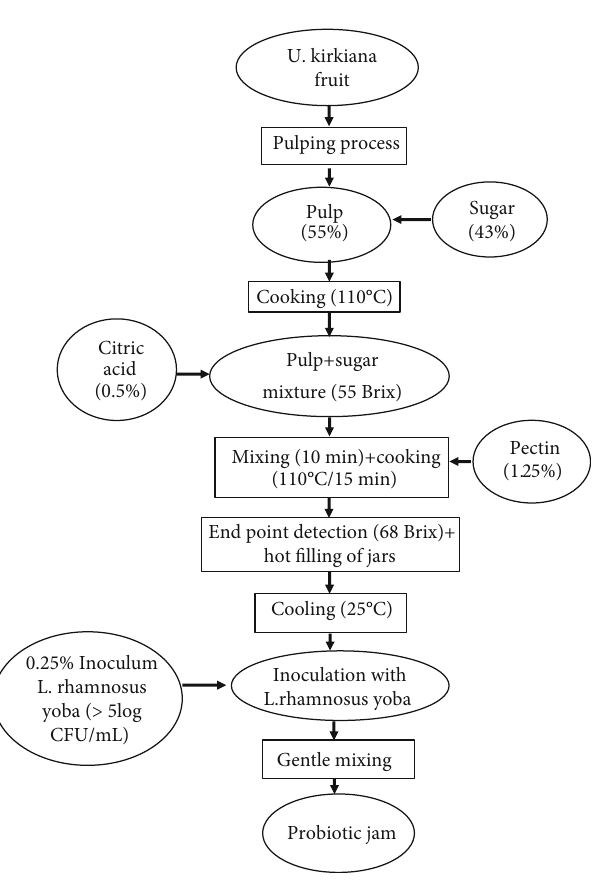
Figure 3: Production process of fruit jam inoculated with